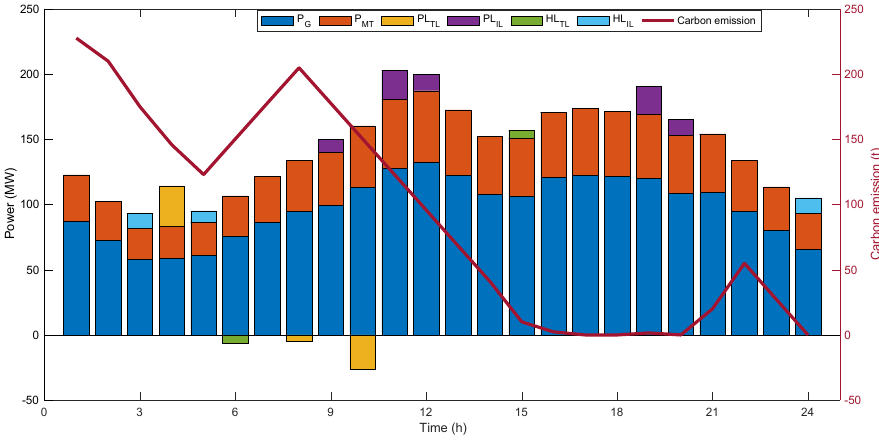
Figure 8. Power dispatch of the MEVPP system under Scenario 2.